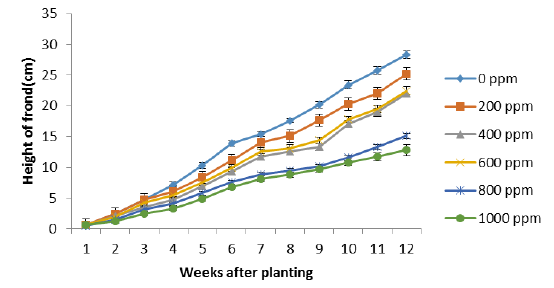
Fig.1. Effect of different treatments of lead on the frond height of Pteris vittata